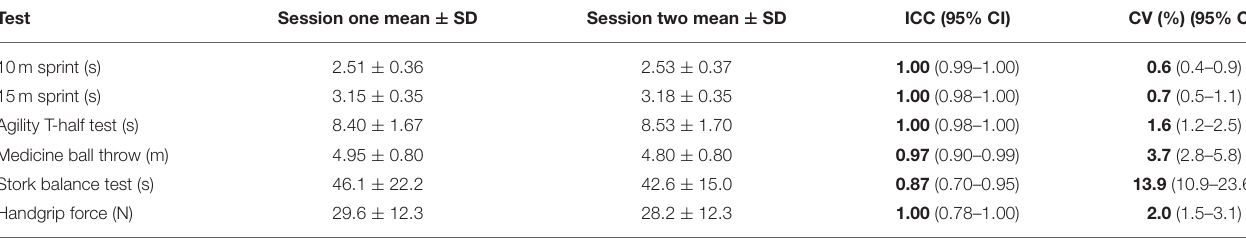
TABLE 1 | Physical fitness tests obtained from two sessions (time interval: n = 23).